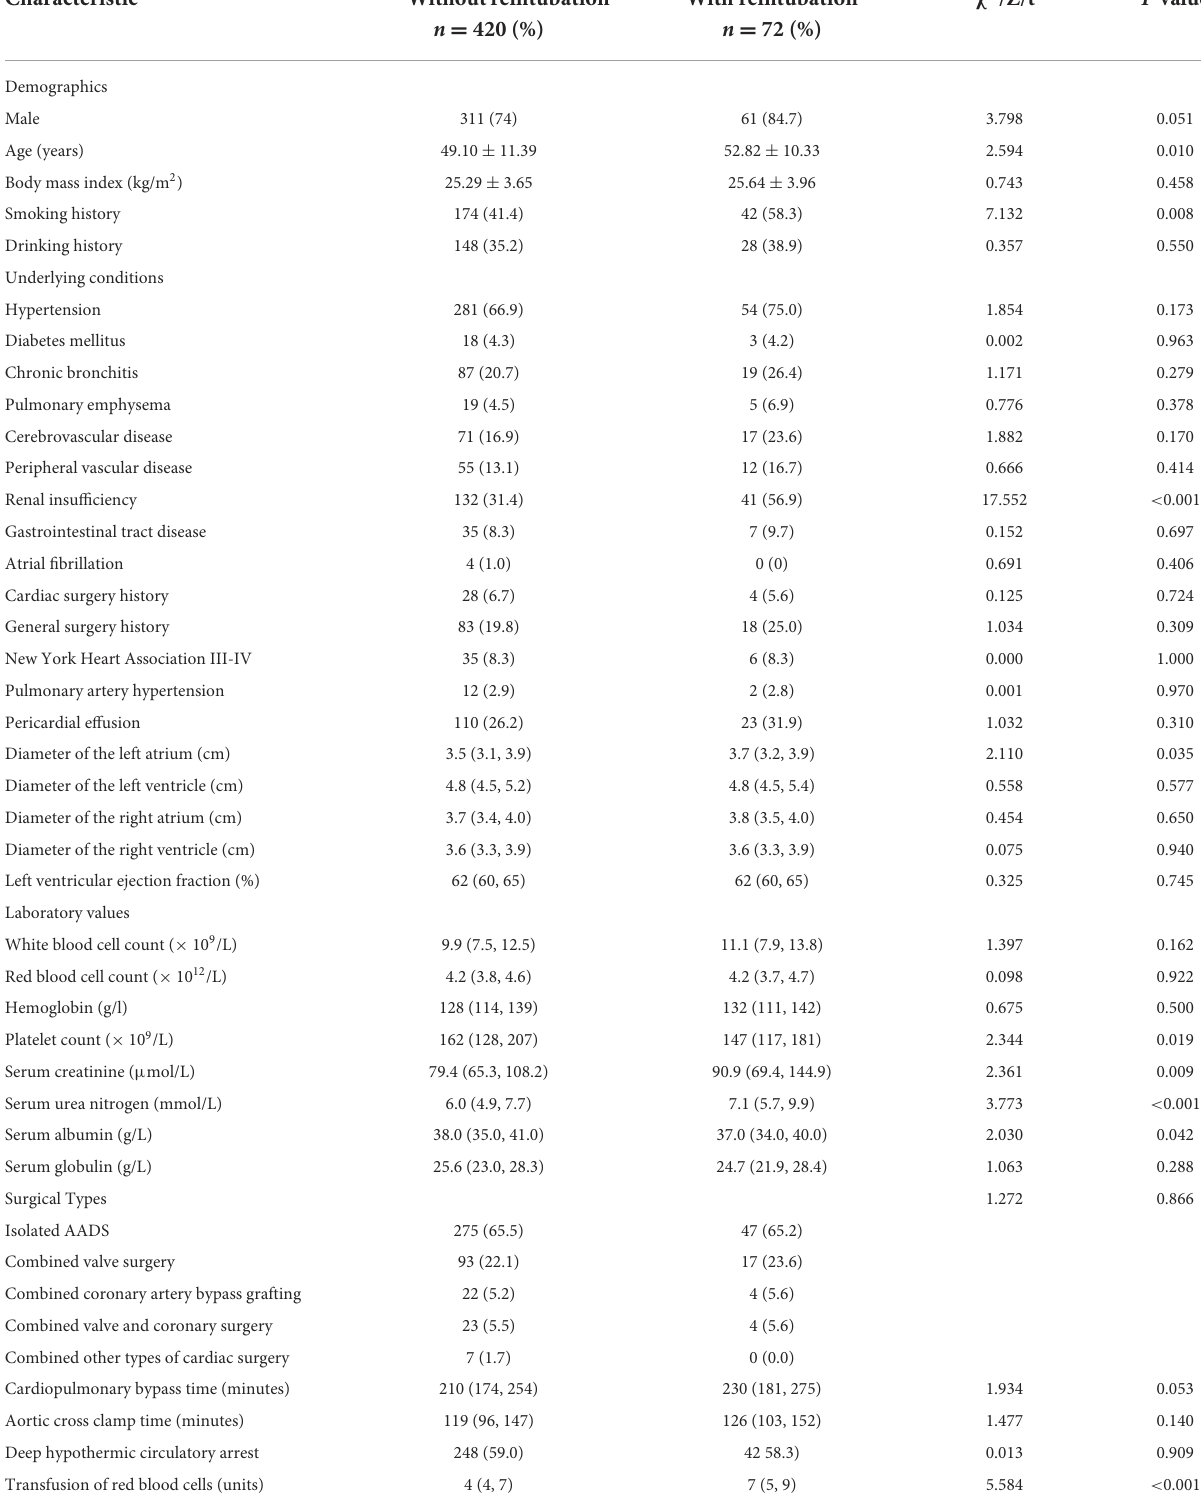
TABLE 1 Univariable analysis of possible predictors for reintubation after AADS.